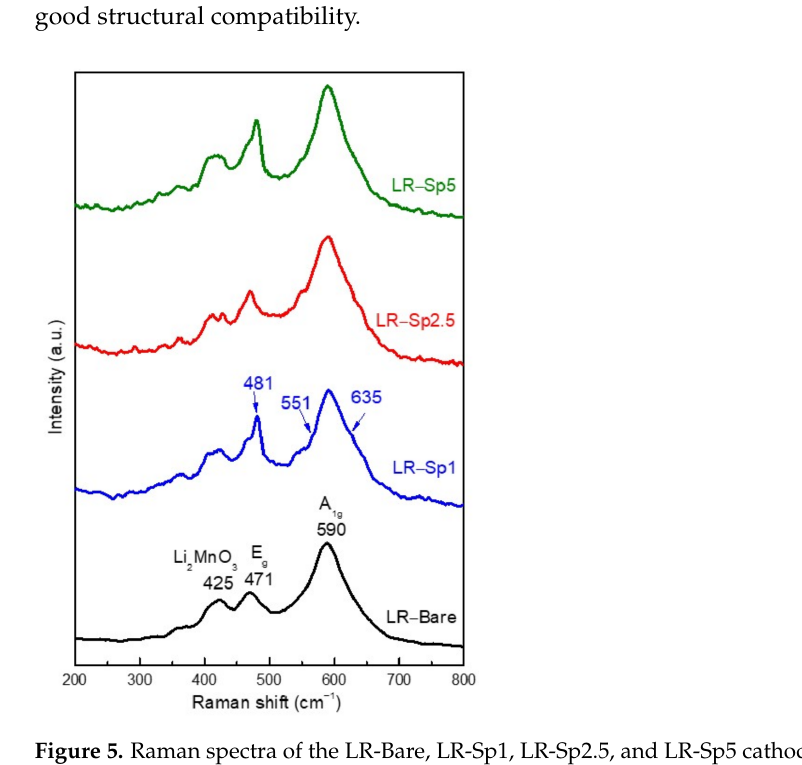
Figure 5. Raman spectra of the LR-Bare, LR-Sp1, LR-Sp2.5, and LR-Sp5 cathodes.